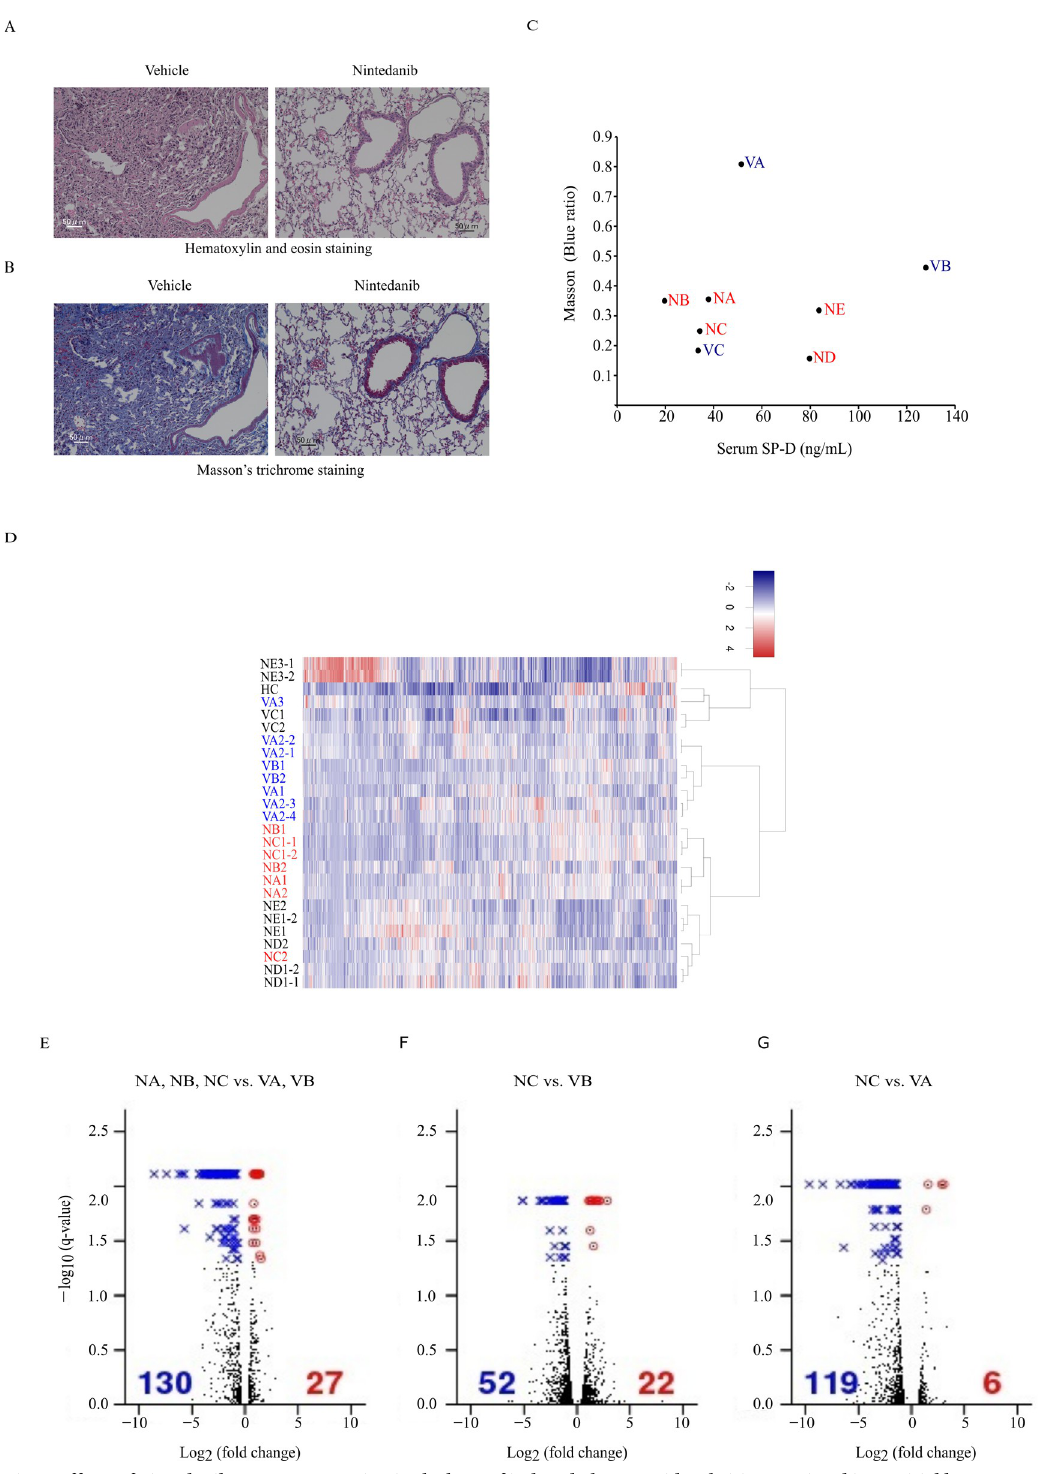
Fig 1. Effects of nintedanib on gene expression in the lung of induced-rheumatoid arthritis–associated interstitial lung disease model mice. (A, B) Histology of vehicle- and nintedanib-treated lung. (C) Relationship between surfactant protein D (SP-D) and Masson stain blue ratio as a measure of the progression of pulmonary fibrosis in nintedanib-treated (NA, NB, NC, ND, and NE) and vehicle-treated (VA, VB, and VC) mice. (D) Gene expression profile clustering for the 26 datasets derived from 5 nintedanib-treated, 3 vehicle-treated, and 1 non-treated (HC) mice. Two major clusters were confirmed: one comprising